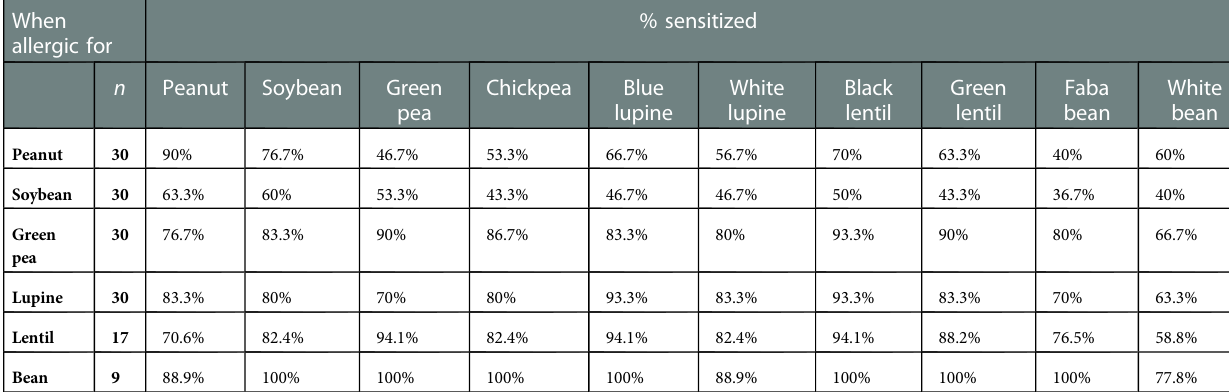
TABLE 1 The frequency of sensitization between 10 legumes in six different legume-allergic patient groups. When allergic